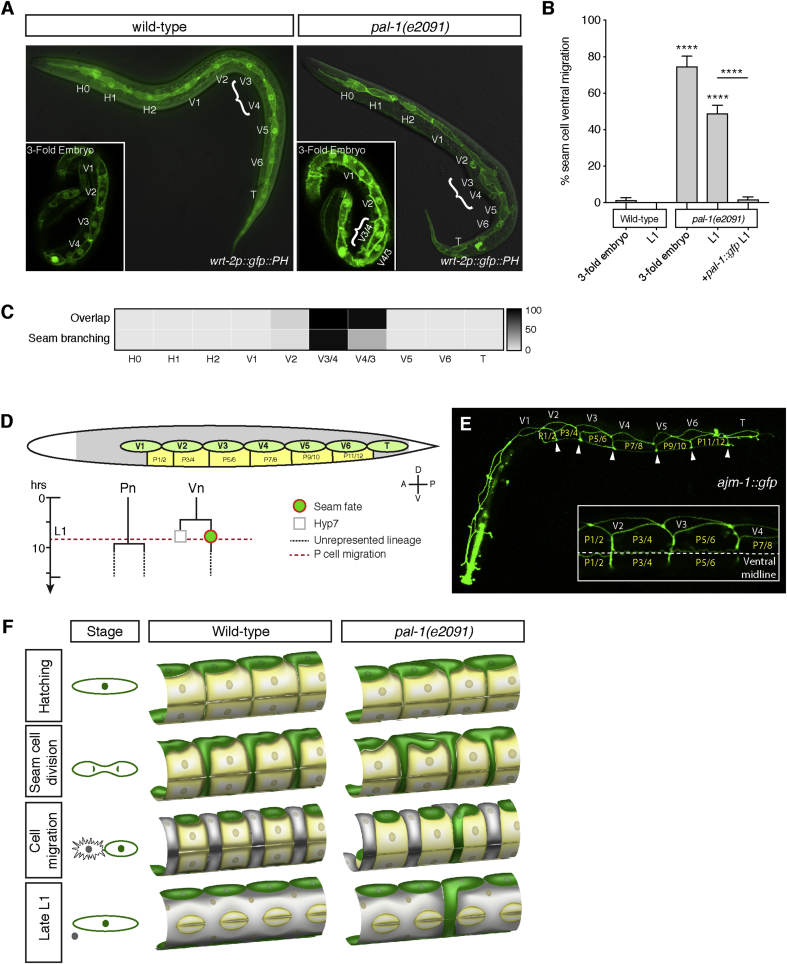
Mis-polarisation of pal-1(e2091) seam cell processes at L1 results from mis-alignment of epidermal cells at hatching.A. Seam cells in a wild-type and pal-1(e2091) mutant at the end of L1. pal-1(e2091) animals exhibit an abnormal clustering of seam cells in the mid-body region, with V lineage cells sharing anteroposterior axes (bracket). This ‘overlap’ phenotype can already be observed in the late (3-fold) embryo (insets). B. Quantification of the seam cell overlap during early development in wild-type and pal-1(e2091) mutants [n ​> ​58 per strain per stage; ****P ​< ​0.0001, two-tailed Student’s t-test]. Overlapping seam cells can be observed as early as the 3-fold embryo in pal-1(e2091) animals. A full-length genomic pal-1::gfp construct completely rescues the L1 phenotype. C. Heat map showing the percentage of cells involved in either the ‘overlap’ or the ventral branching seam phenotype in pal-1(e2091) animals. The identity of each seam cell (Vn, Vn+1…) is approximated with respect to its a-p position. As is evident in Fig. 5, embryonic lineaging later demonstrates that V3 and V4 become reversed in the seam line in pal-1 embryos, thus V3 and V4 are likely to be also reversed at L1, hence the ambiguous labelling V3/V4. There is a strong correlation between cells that are involved in the seam cell overlap phenotype and the identities of those seam cells that migrate to the ventral mid-line [two-way anova, P ​< ​0.0001]. D. Schematic showing the position of medial and posterior seam (Vn and T) and P cells in a wild-type worm at hatching. The seam cells (green) lie in two lateral rows either side of the animal, and at this stage the P cells (yellow) lie ventrally. The dorsal hyp7 syncytial epidermis is shown in grey. L1 lineages of the Pn and Vn cells are represented along with a dashed red line indicating the time in L1 at which the P cells migrate to the ventral midline (timings from Sulston and Horvitz, 1977). E. Seam and P cells at hatching, showing the apical junctions between cells using ajm-1::gfp. Arrowheads indicate the apical junctions between P cells where the seam cell projection forms during division. The inset shows a lateral-ventral view of P cells either side of the ventral midline. F. Graphic representation of the lateral-ventral surface in wild-type and pal-1(e2091) animals during L1. The first column indicates the stage of seam cell division. In wild-type, seam cells are lined up with respect to the P cells such that their anterior portion is adjacent to the apical junction between P cells. Seam cells form a process to the ventral midline through this junction. During division, the P cells shrink and migrate to the ventral midline, allowing the seam cell anterior process to form a pathway through which the anterior seam cell daughter can migrate into the ventral space. Posterior seam-fated daughters retain their lateral position. pal-1(e2091) mutant animals hatch with a mis-alignment of seam cells in the mid-body region, the ‘overlap’ phenotype. This causes seam cells in this region to be mis-aligned with respect to the ventral P cells, such that the apical junction between P cells in this region lies adjacent to the posterior, not anterior, portion of the seam cell. This seam cell, therefore, extends a process from the posterior side of the cell to the ventral midline, through the P cell apical junction. As seam cell division progresses, the wrong cell, i.e. the posterior seam cell daughter, inherits the process and erroneously moves into the ventral space in place of the anterior hyp7 daughter. This misplaced cell retains the seam cell proliferative fate and does not fuse to hyp7.